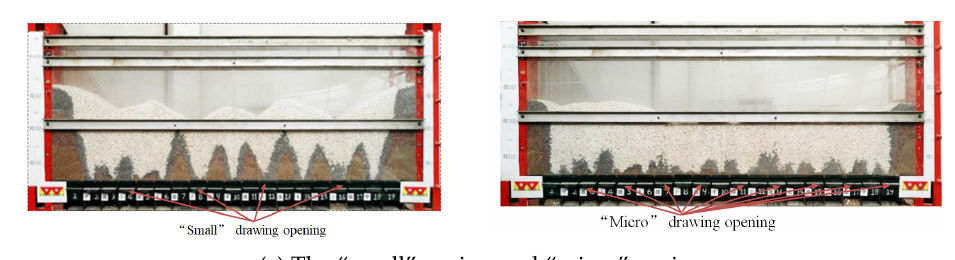
Figure 11. Evolution process of coal-rock morphology in front of test platform.